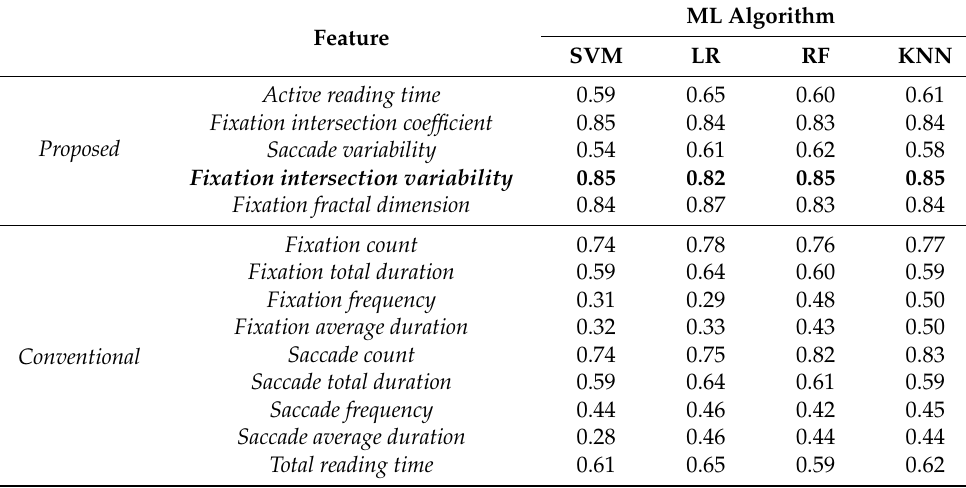
Table A1. Sensitivity for single feature inputs.